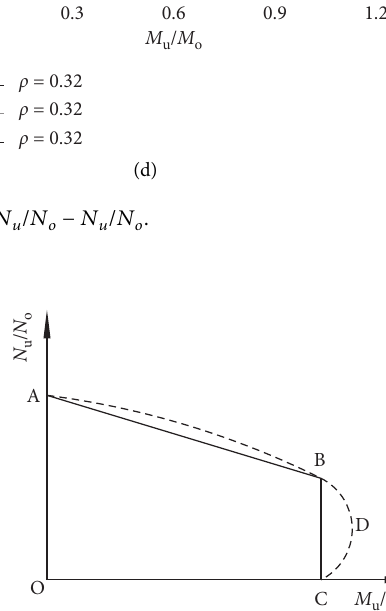
Figure 12: The simplified curve for N